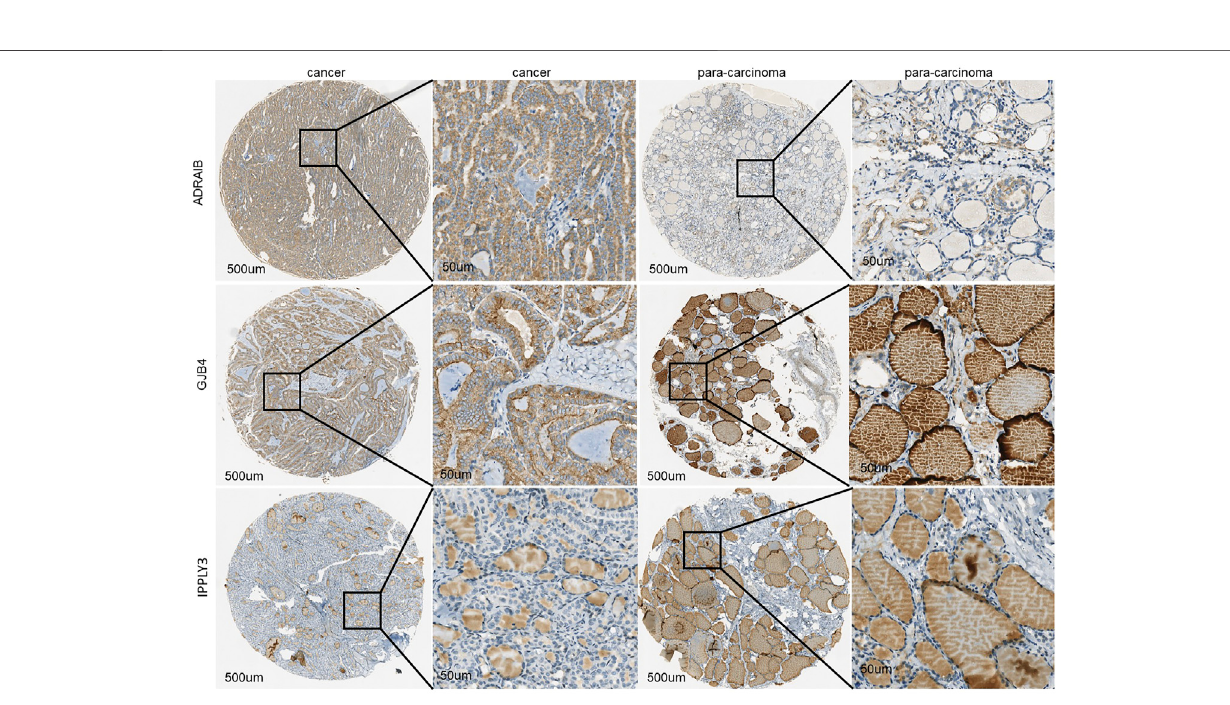
Frontiers in Molecular Biosciences |